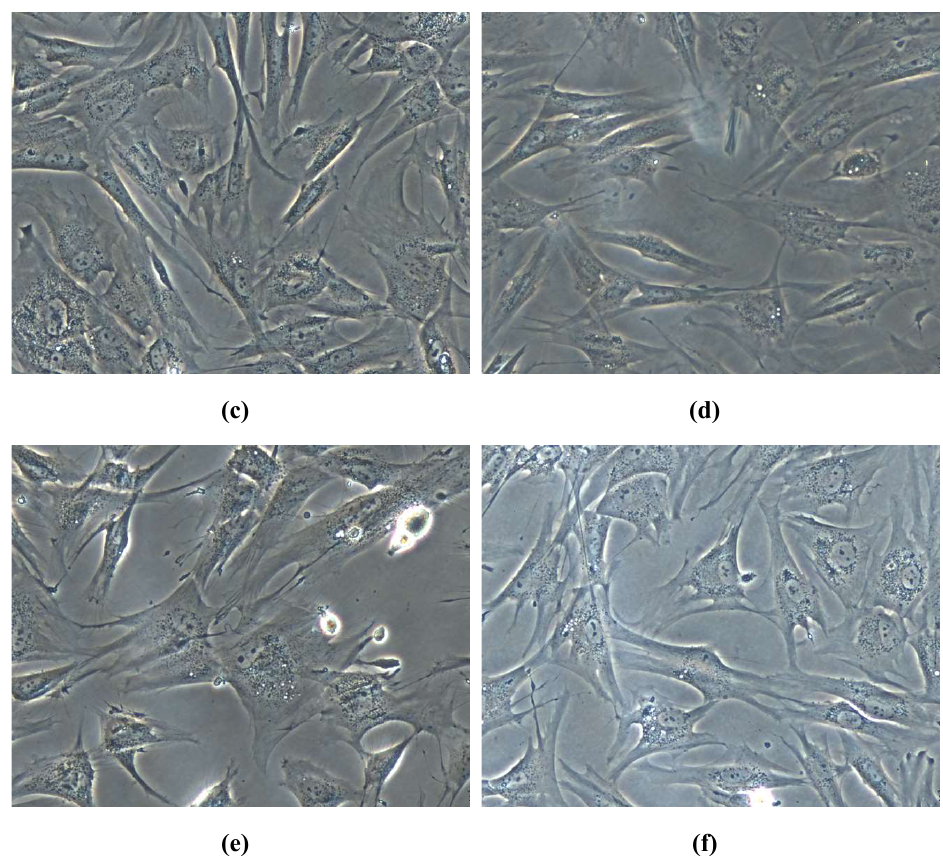
Figure 7. Optical microscopy images of human amniotic fluid stem cells (AFSC) cultures developed at 3 days in the presence of the obtained ZnO nanomaterials H1 ( a ), H2 ( b ), H3 ( c ) and P1 ( d ), P2 ( e ) and cell control ( f ).